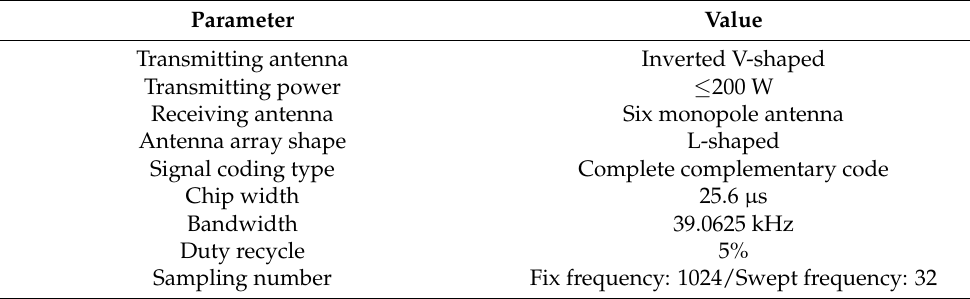
Table 1. The main parameters of